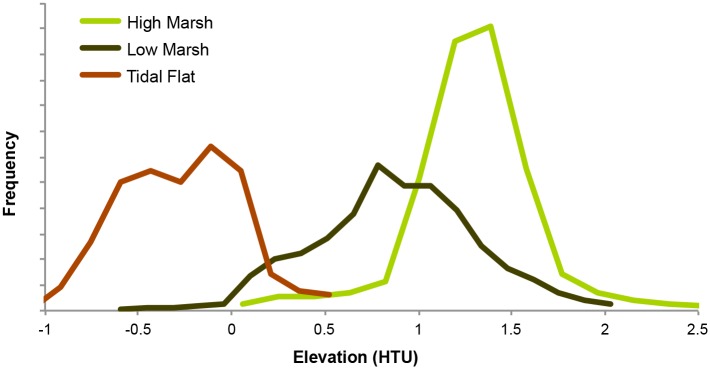
The frequency of occurrence of the model’s tidal wetland classes along an elevation gradient.Data shown are for the northern portion of the study area, and exclude any values that were well outside of the elevation range of each wetland class. This pattern of elevational frequency for the three tidal wetland classes is representative of both the north and south sections of the study area.